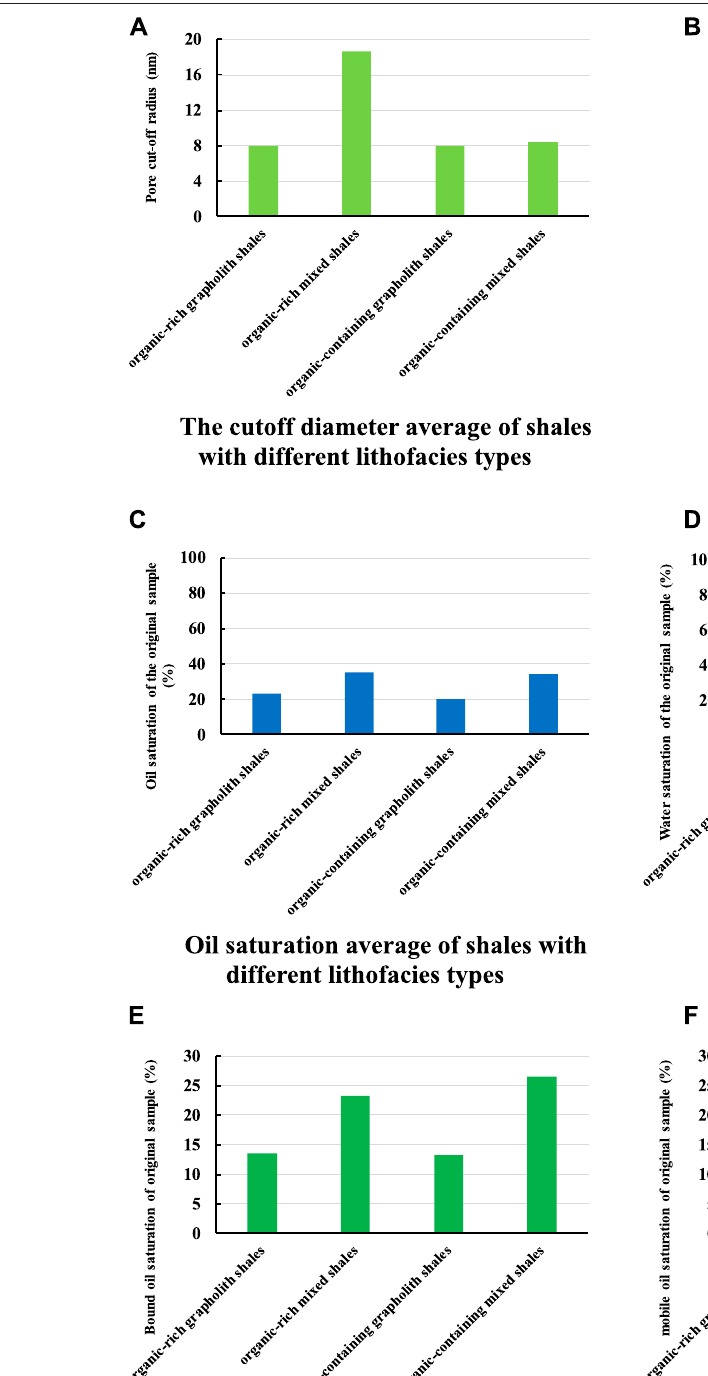
FIGURE 5 | Evaluation diagram of the shale pore cutoff diameter and pore fl uids of shales with different lithofacies types. (A) The cutoff diameter average of shales with different lithofacies types. (B) Pore fl uids model. (C) Oil saturation average of shales with different lithofacies types. (D) Water saturation average of shales with different lithofacies types. (E) Bound oil saturation average of shales with different lithofacies types. (F) Mobile oil saturation average of shales with different lithofacies types.